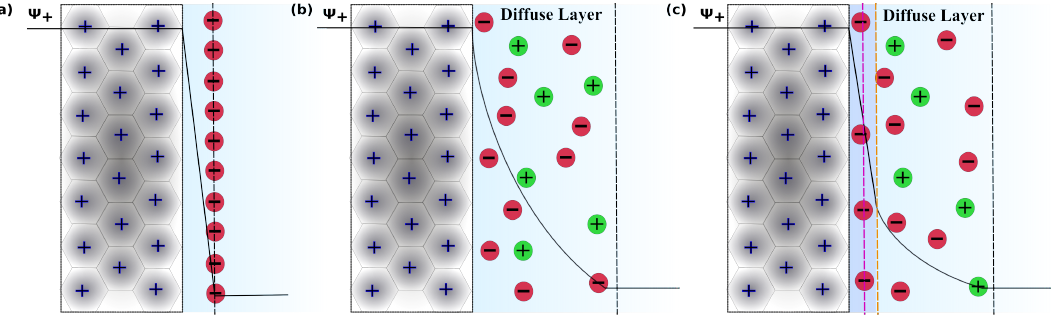
Figure 1. Different descriptions of the electric double layer (EDL) over time. ( a ) The Helmholtz model, ( b ) the Gouy–Chapman model, and ( c ) the Gouy–Chapman–Stern model. The Stern layer is composed of the Inner Helmholtz plane (pink dashed line) and Outer Helmholtz plane (orange dashed line). Ψ + represents the potential as a function of distance from the positive